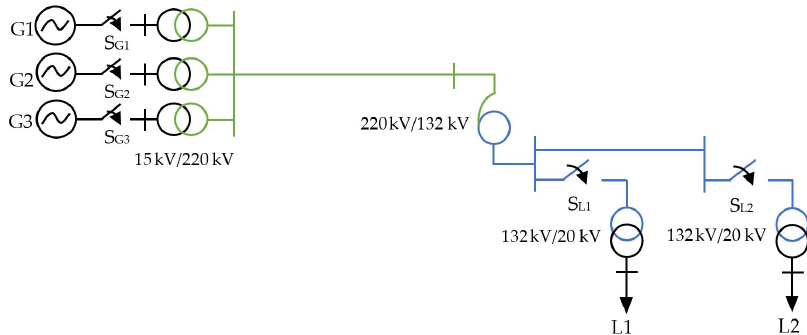
Figure 7. Simplified single-line scheme of the restoration path.